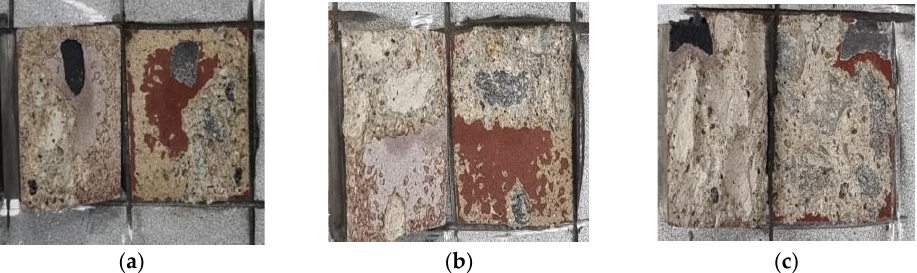
Figure 9. Non-interfacial failure mode according to surface treatment conditions. ( a ) SRA; ( b ) SH – SRA; ( c ) SH – SRA – SA.